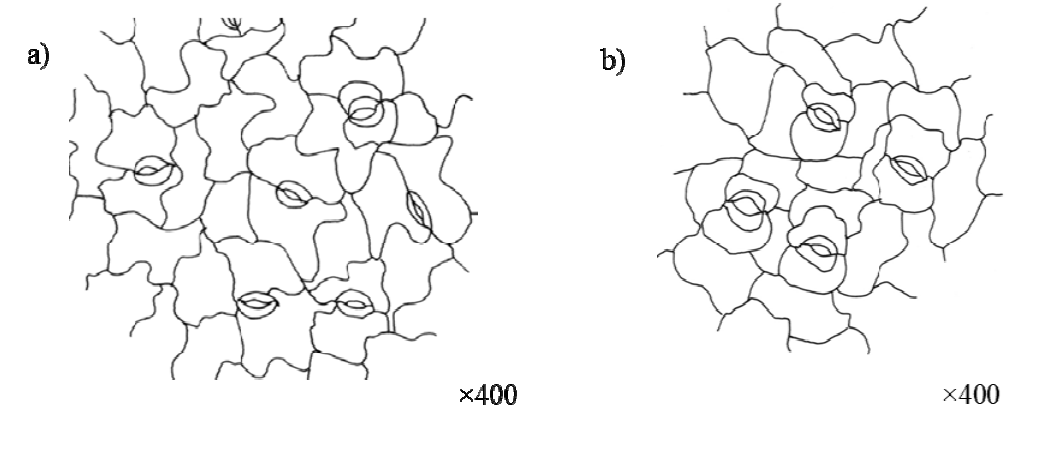
Fig. 1. Abaxial surface of Abelmuschus esculentus ‘Clemson’ spineless variety (a) and Abelmuschus esculentus 40 days local variety showing paracytic stomata; ×400